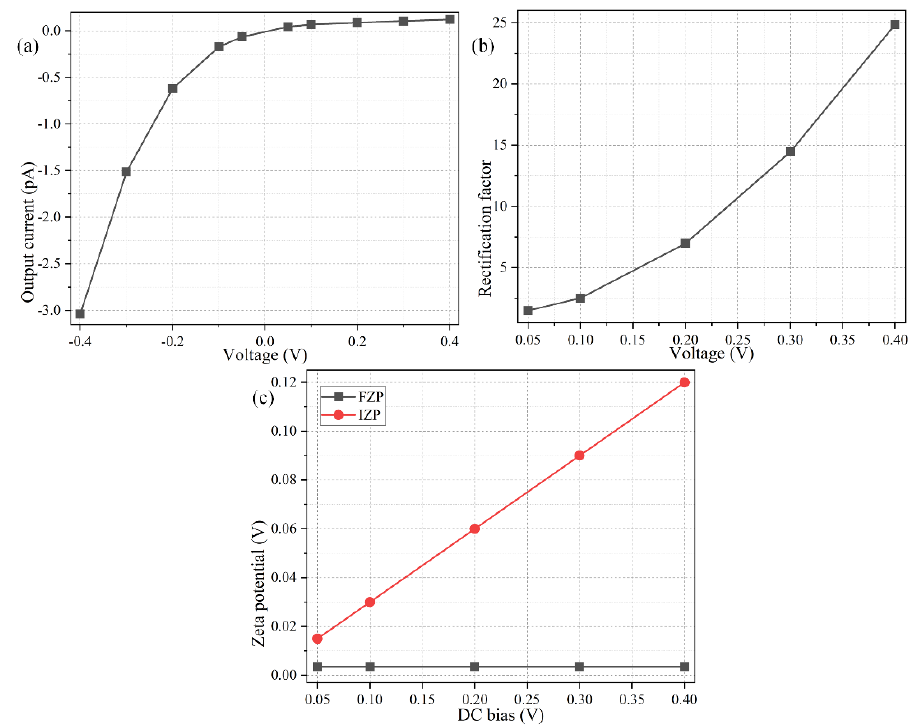
Figure 10. Effect of the imposed DC voltage across the S-D terminal on the rectifying functionality of the nanofluidic ion diode, under a given parametric space of L C = 600 nm, σ free = −0.001 C/m 2 , c 0 = 3.7 mM, and 2 R N = λ D = 5 nm. ( a ) Voltage-dependence of the output electric current. ( b ) Voltage-dependence of the rectification factor. ( c ) Analytical approximation of FZP and IZP as a function of the imposed DC bias across the nanopore length direction.